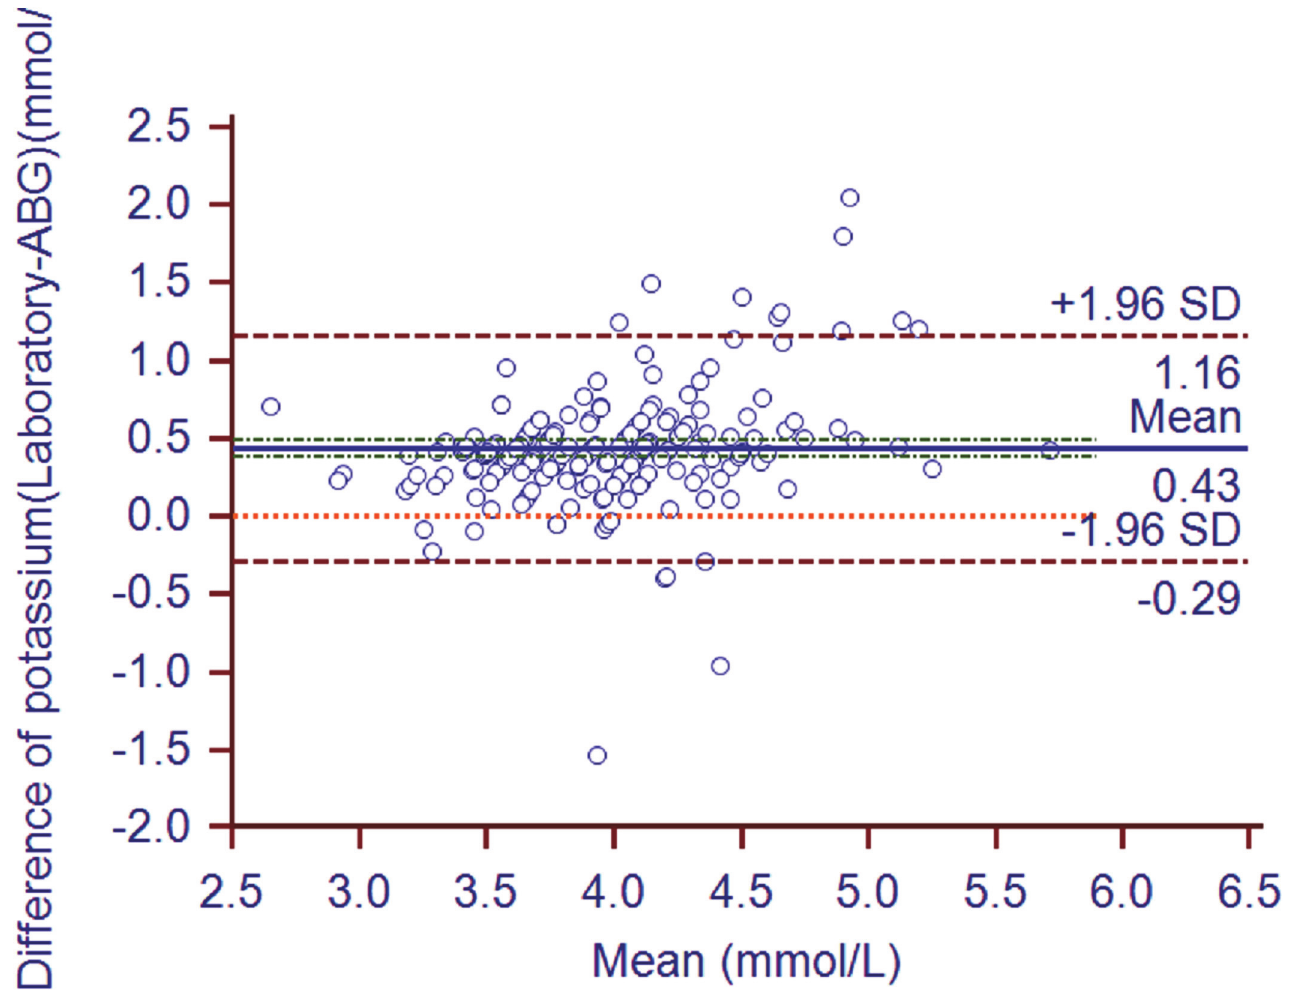
Fig 1. Potassium bias plot. Bland and Altman plot shows the potassium bias of each pair of samples (in mmol/L). The solid line indicates the mean bias and the value is 0.43. The green line indicates 95%CI of mean bias (0.38 to 0.48). The brown line indicates the 95% LOA of the bias (-0.29 to 1.16). The orange line indicates zero